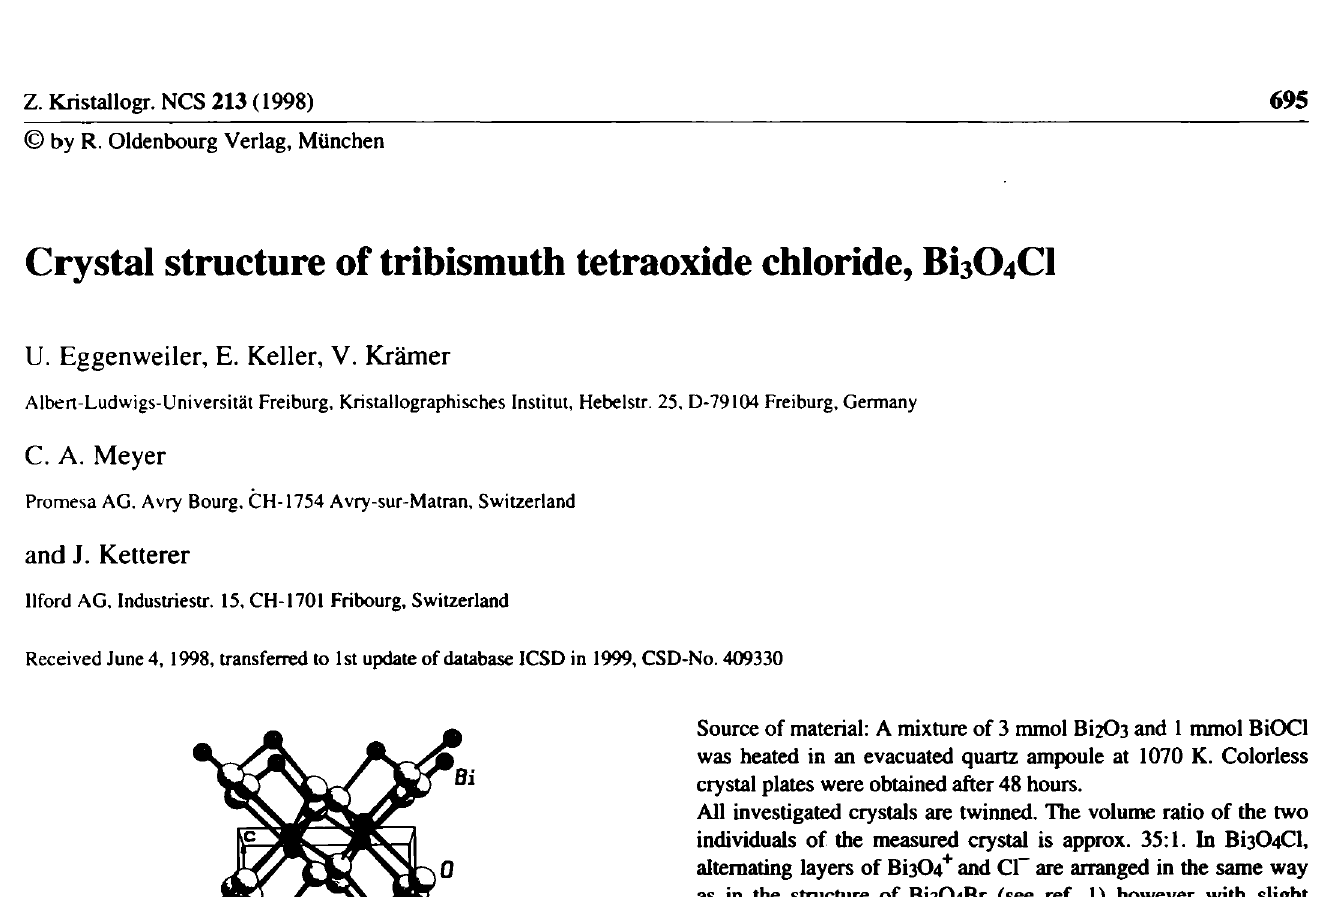
Table 1. Parameters used for the X-ray data collection Crystal: